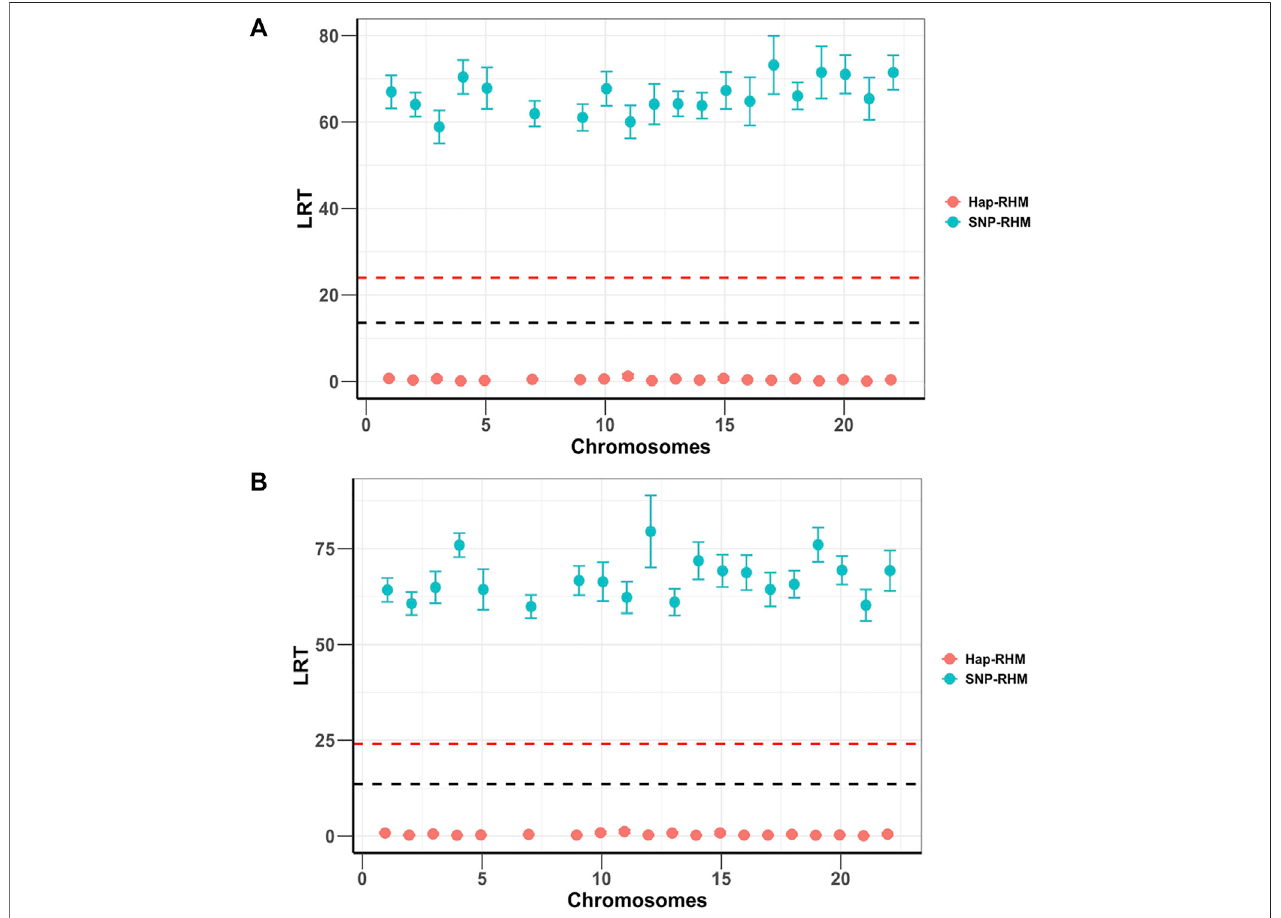
FIGURE3| PlotsofaverageLRTstatisticsoverreplicatesofQTLlociacrossthechromosomesforthe20simulationsofeachofthetwoSNPQTLphenotypes.The red dashed lines are genome-wide signi fi cance threshold (for 48,772 regions) and the black dashed lines are Bonferroni signi fi cance threshold (for 220 regions). The upper plot (A) is the 1-SNP QTL phenotype, and the lower plot (B) is the multiple SNP QTL phenotype. The two phenotypes are analysed using both the SNP based model (SNP-RHM) (blue points) and the Haplotype based model (Hap-RHM) (red points). The Hap-RHM fails to capture the simulated effects for the SNP QTLs.